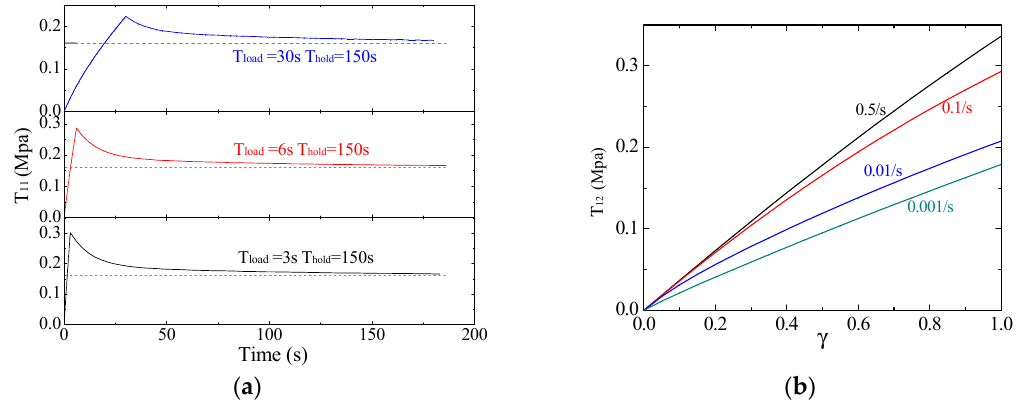
Figure 5. Virtual experiment data ( a ) relaxation tests of uniaxial tension ( b ) simple shear tests.